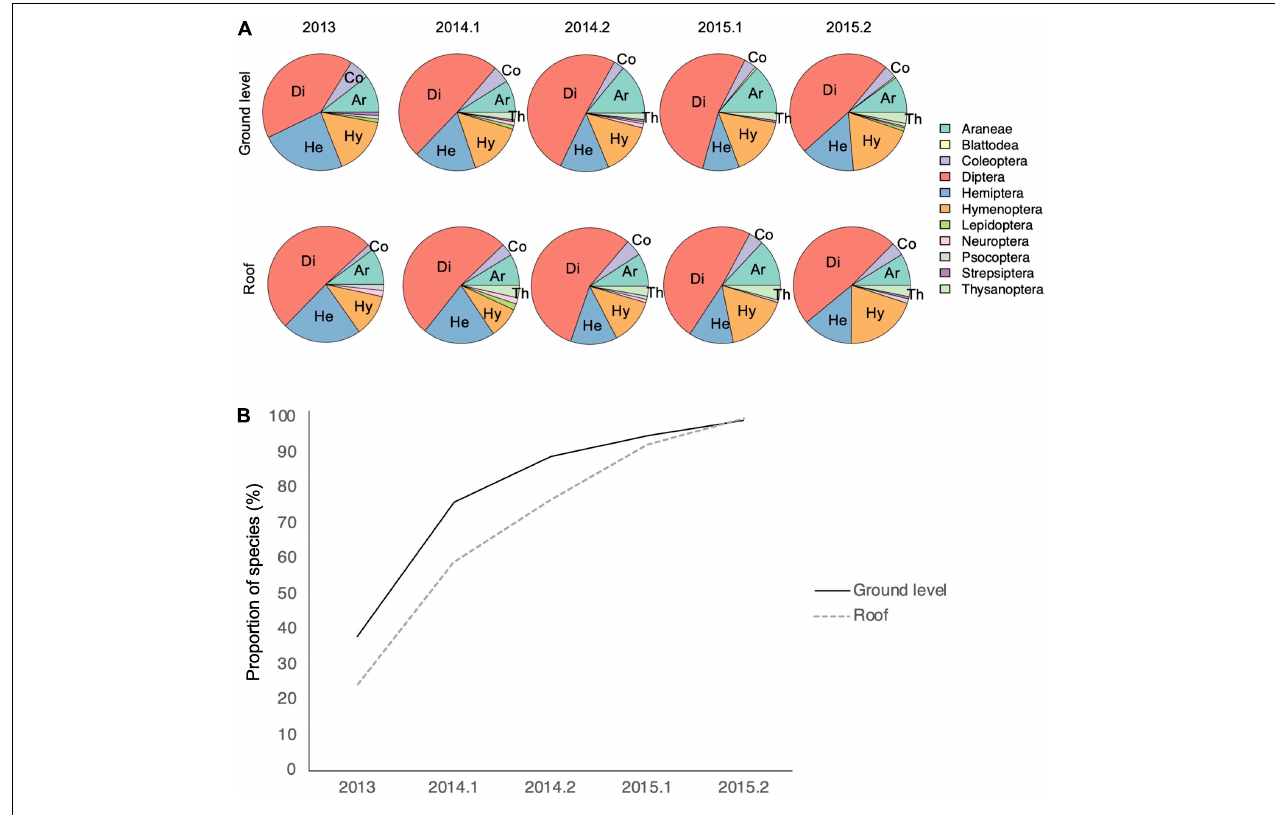
FIGURE 2 | Proportions of OTUs by order on the roofs and in ground level sites (A) and the accumulation of OTUs in our roof data at the ground level reference sites and on roofs (B) . Abbreviations of the most species rich orders are marked in the figure: Ar, Araneae; Co, Coleoptera; Di, Diptera; He, Hemiptera; Hy, Hymenoptera; Th, Thysanoptera. The y -axis in panel (B) shows the proportion of species, which were collected from roofs, by sampling occasion ( x -axis: 0.1 = early summer, 0.2 = late summer) in the ground level sites (solid line) and on roofs (dashed line). Data from the two sampling occasions in 2013 are combined (A,B) . Data for Thysanoptera are missing from